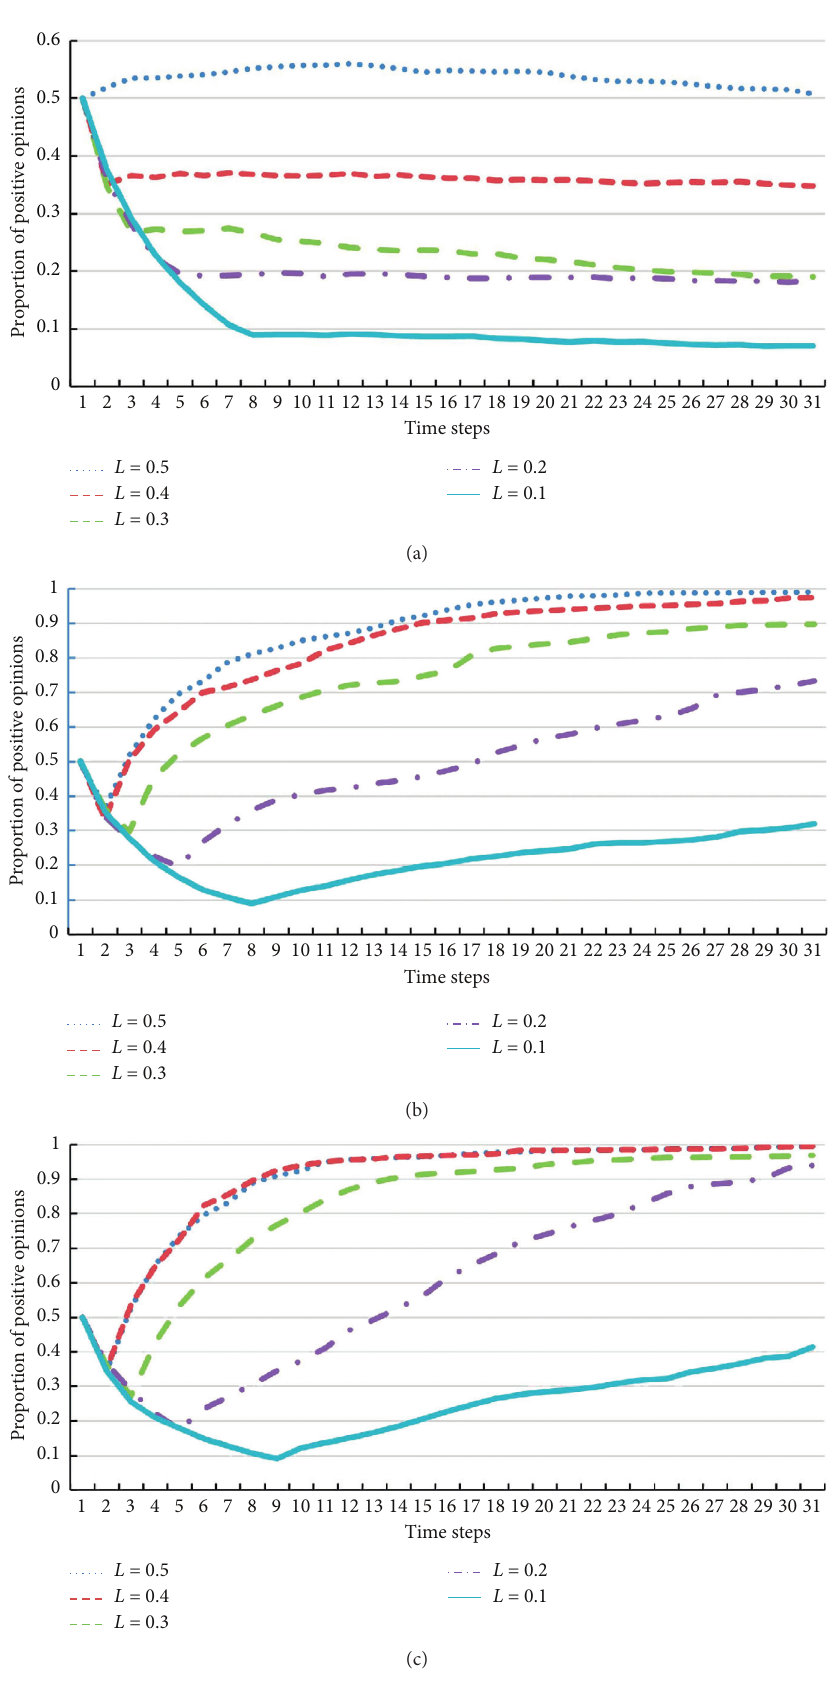
Figure 7: The evolution trends for the initial proportion pp � 0 . 5, opinion control levels k � 1 , 3 , and 5, and L � 0 . 5 , 0 . 4 , 0 . 3 , 0 . 2 , and 0 . 1 in � 20 and m � 5. (a) The initial proportion pp � 0.5, C � 2, and L � 0.5, 0.4, 0.3, 0.2, and 0.1. (b) The initial scale-free networks with m 0 proportion pp � 0.5, C � 6, and L � 0.5, 0.4, 0.3, 0.2, and 0.1. (c) The initial proportion pp � 0.5, C � 10, and L � 0.5, 0.4, 0.3, 0.2, and